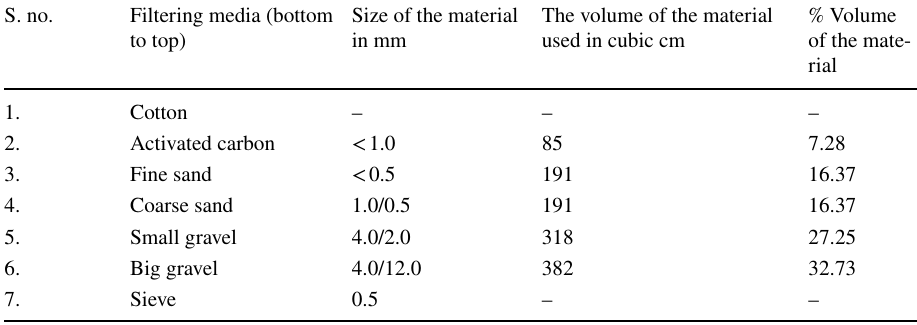
S. no. Filtering media (bottom to